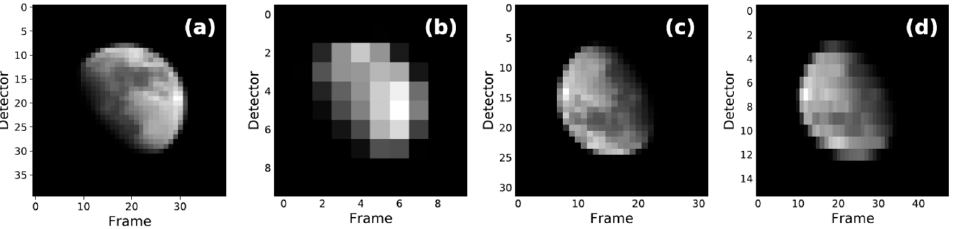
Figure 2. Lunar images acquired on 24 January 2021. ( a ) Aqua MODIS band 1. ( b ) Aqua MODIS band 8. ( c ) SNPP VIIRS band I1. ( d ) SNPP VIIRS band M1. In ( d ), the pixel aspect ratio was set to 3:1 in order to produce a circular Moon image.